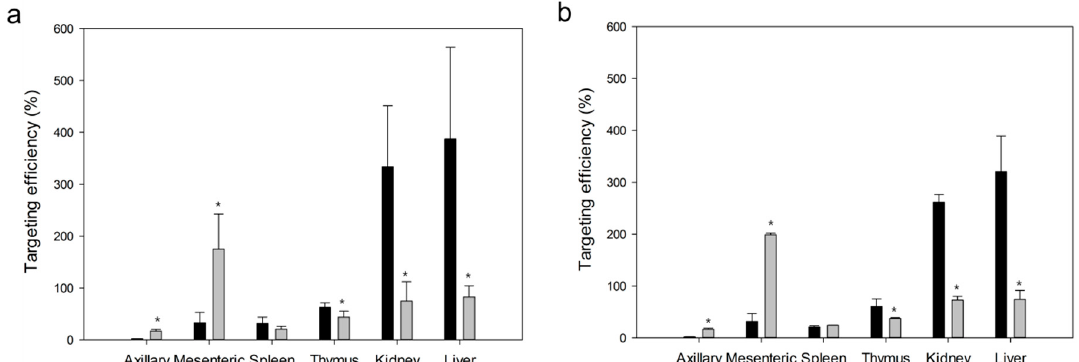
Figure 13. Targeting efficiencies of MTX to axillary and mesenteric lymph nodes, spleen, thymus, kidney and liver at 2.5 h after oral ( a ) or intravenous ( b ) administration of MTX-loaded PLGA NPs ( ■, 5 mg / kg as MTX) and free MTX ( (cid:4) , 5 mg / kg) to rats. Vertical bars represent mean ± SD ( n =